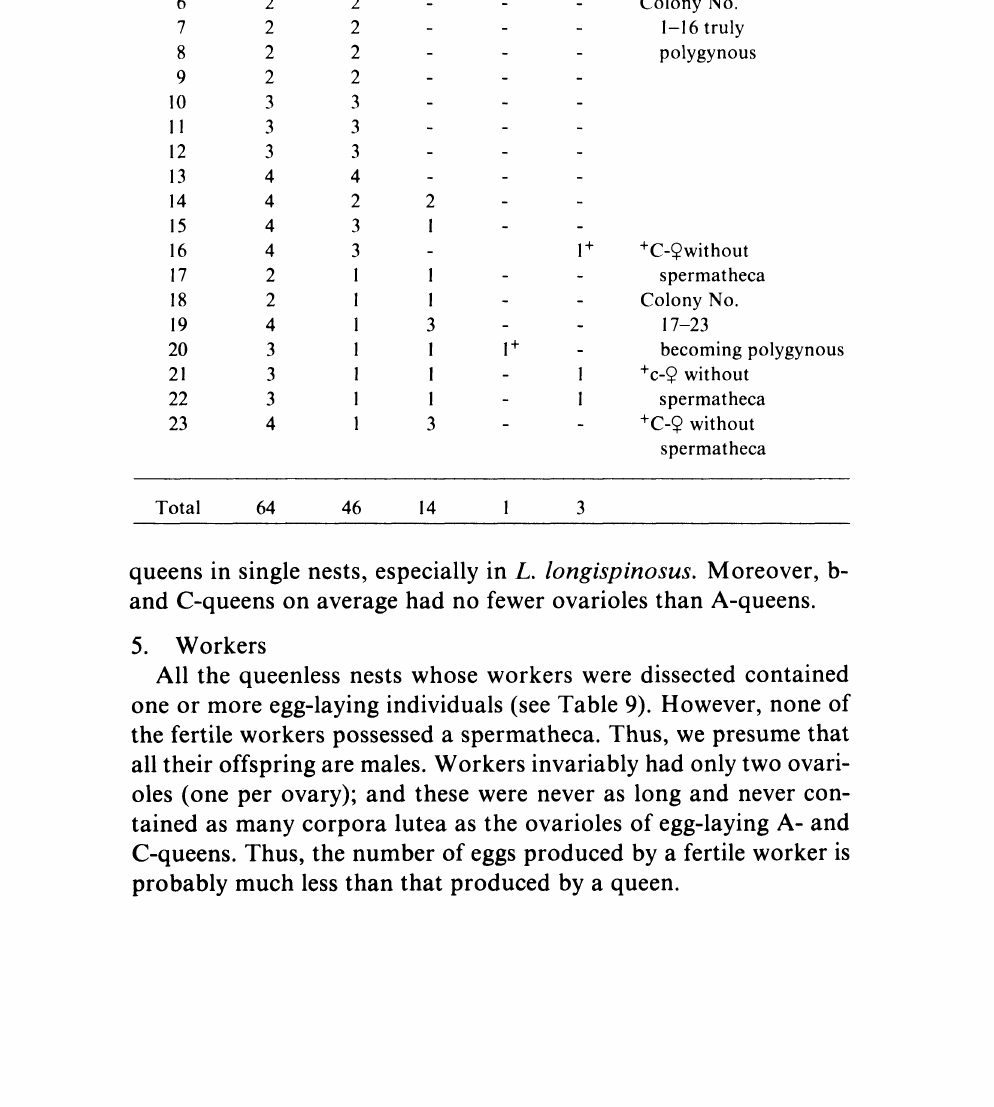
Table 6. Numbers and Type of Dealate Females in Multiple-Queen Colonies of Leptothorax curvispinosus Colony n Dealate No. A-Q